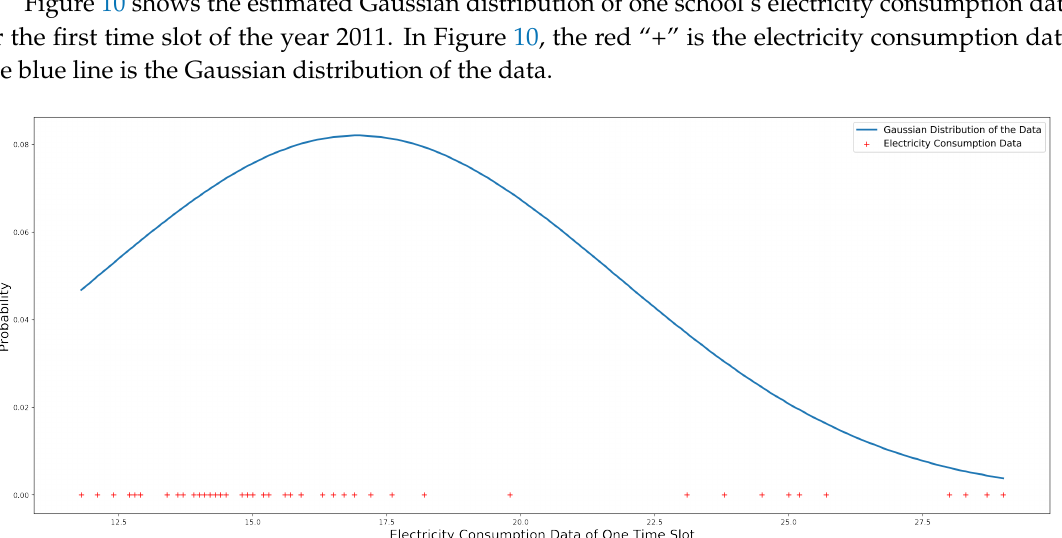
Figure 10. Gaussian distribution of the first time slot’s electricity consumption data. Adapted from